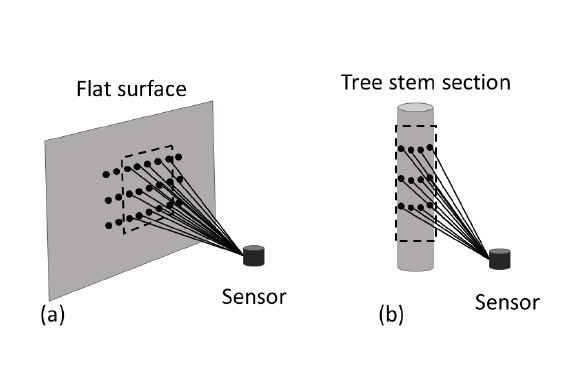
Figure 2. Schematic illustration of the kernel (dashed line) used for detection of flat surfaces (a) and stem sections of a tree